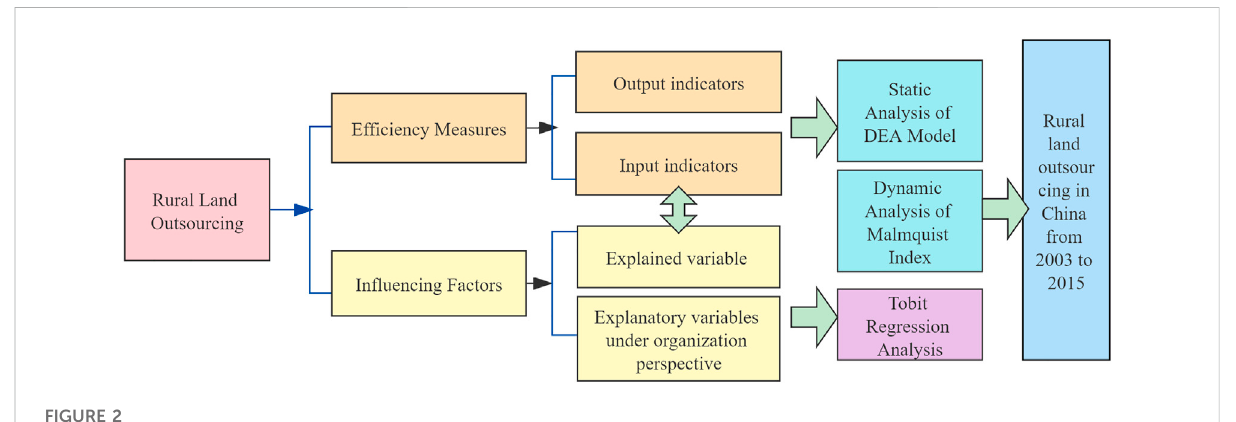
FIGURE 2 Research methods and procedures.